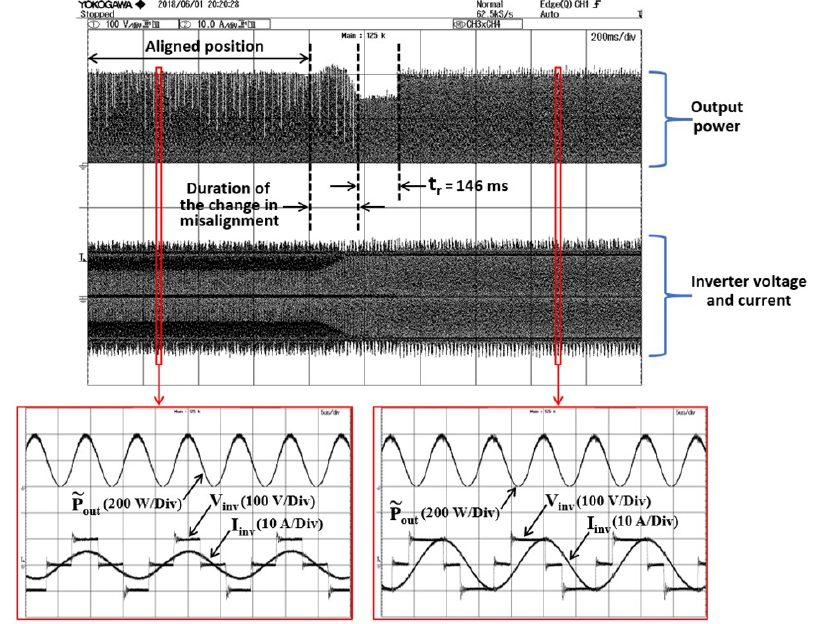
Figure 11. Experimental results of the output power regulation when kettle is moved 7 cm from aligned